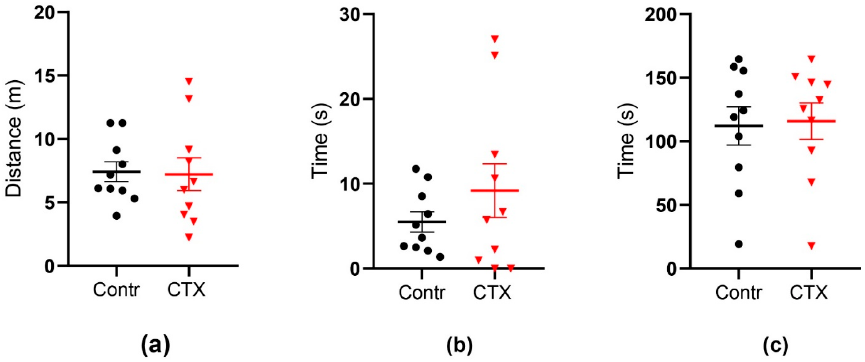
Figure 5. The behavior of CTX-treated rats in the open field test does not change. ( a ) Distance traveled by a rat during the testing time, ( b ) the time rat spent in the center of the arena, ( c ) the time rat spent in thigmotaxis. Data are presented as a mean with a standard error of the mean. Each dot (circle, triangle) represents a value obtained in individual animal.